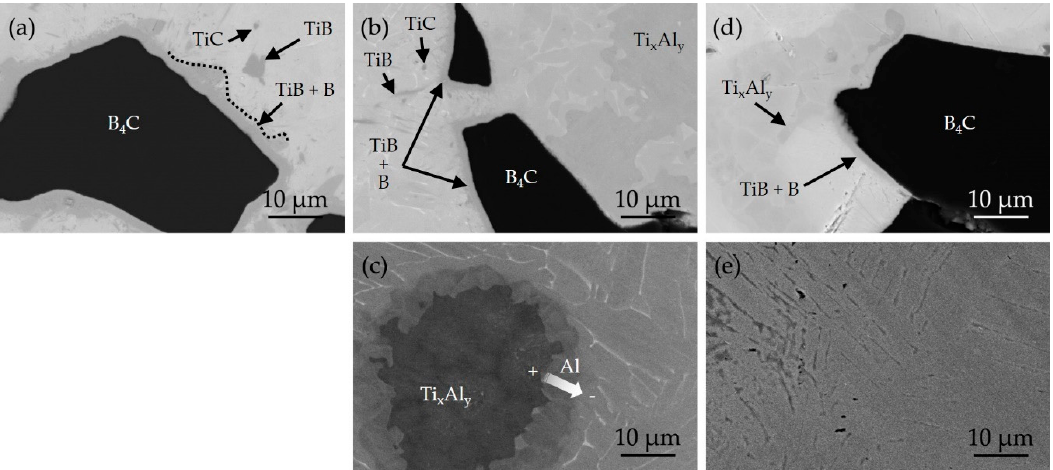
Figure 3. Phases identification via CBS-SEM images: ( a ) Ti + 30 vol. % B 4 C, ( b ) Ti + 30 vol. % B 4 C + 20 vol. % Ti-Al(1), ( c ) Ti + 20 vol. % Ti-Al(1), ( d ) Ti + 30 vol. % B 4 C + 20 vol. % Ti-Al(2) and ( e ) Ti + 20 vol. % Ti-Al(2).